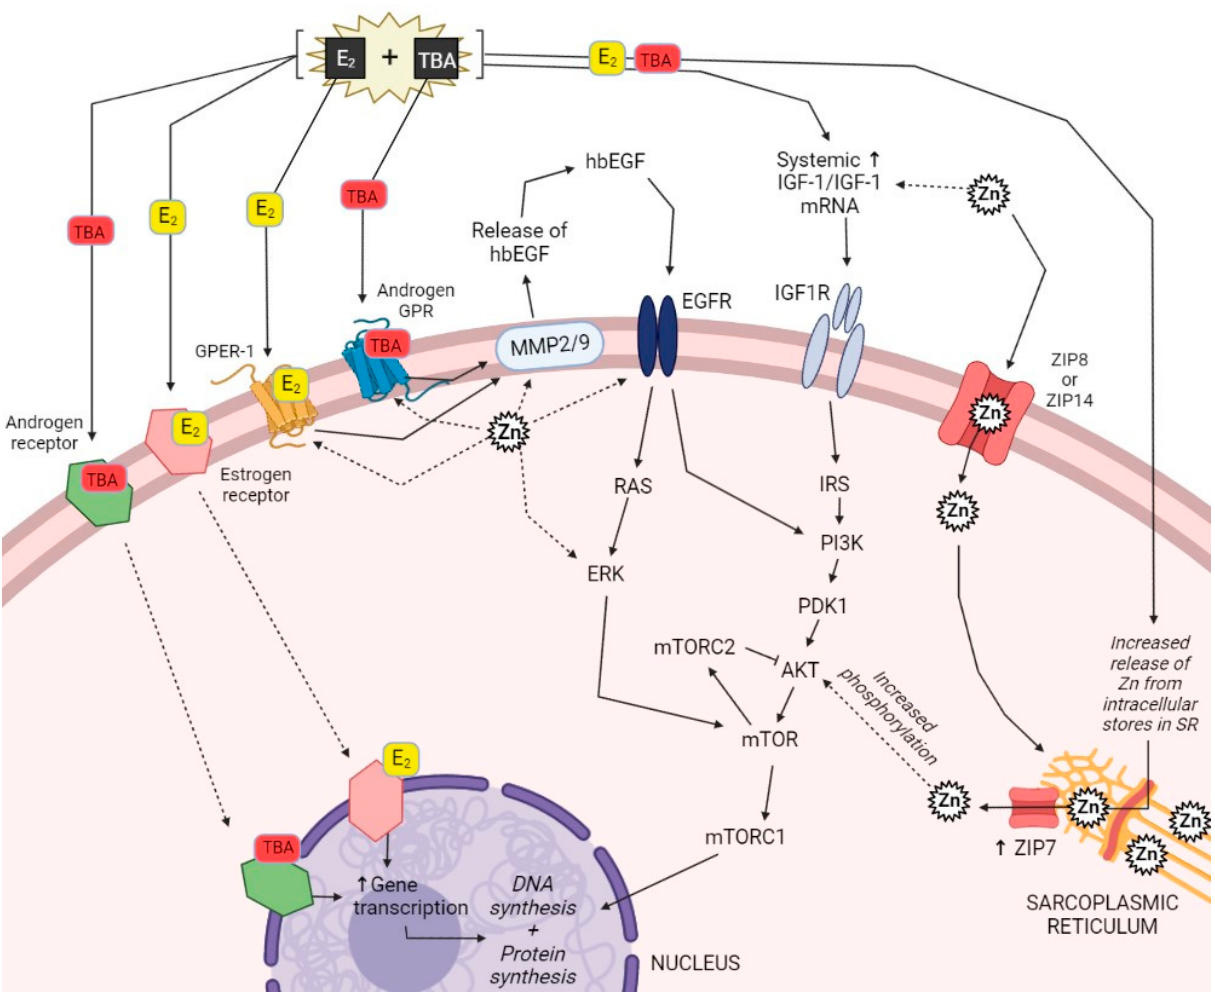
Figure 1. Proposed physiological pathway interactions of combination E 2 + TBA steroidal implants and Zn in skeletal muscle cells as discussed in this review. Specific focus is placed on the genomic and non-genomic steroid hormone pathways, protein and DNA synthesis pathway, and the corresponding points at which evidence suggests Zn interacts with these pathways. Definitions: AKT (Protein kinase B), Androgen GPR (Androgen specific G protein-coupled receptor), E 2 (Estradiol), EGFR (Epidermal growth factor receptor), ERK (Extracellular signal-regulated kinase), GPER-1 (G protein-coupled estrogen receptor 1), hbEGF (Heparin binding epidermal growth factor-like growth factor), IGF-1 (Insulin-like growth factor 1), IGF1R (Insulin-like growth factor 1 receptor), IRS (Insulin receptor substrate), MMP2/9 (Matrix metalloproteinase 2/9), mTOR (Mammalian target of rapamycin), mTORC1 (Mammalian target of rapamycin 1), mTORC2 (Mammalian target of rapamycin 2), PDK1 (Phosphoinositide-dependent kinase-1), PI3K (Phosphoinositide 3-kinases), RAS (Ras family of related GTPase proteins), SR (Sarcoplasmic reticulum), TBA (Trenbolone acetate), ZIP7 (Zinc transporter SLC39a7), ZIP8 (Zinc transporter SLC39a8), ZIP14 (Zinc transport SLC39a14).